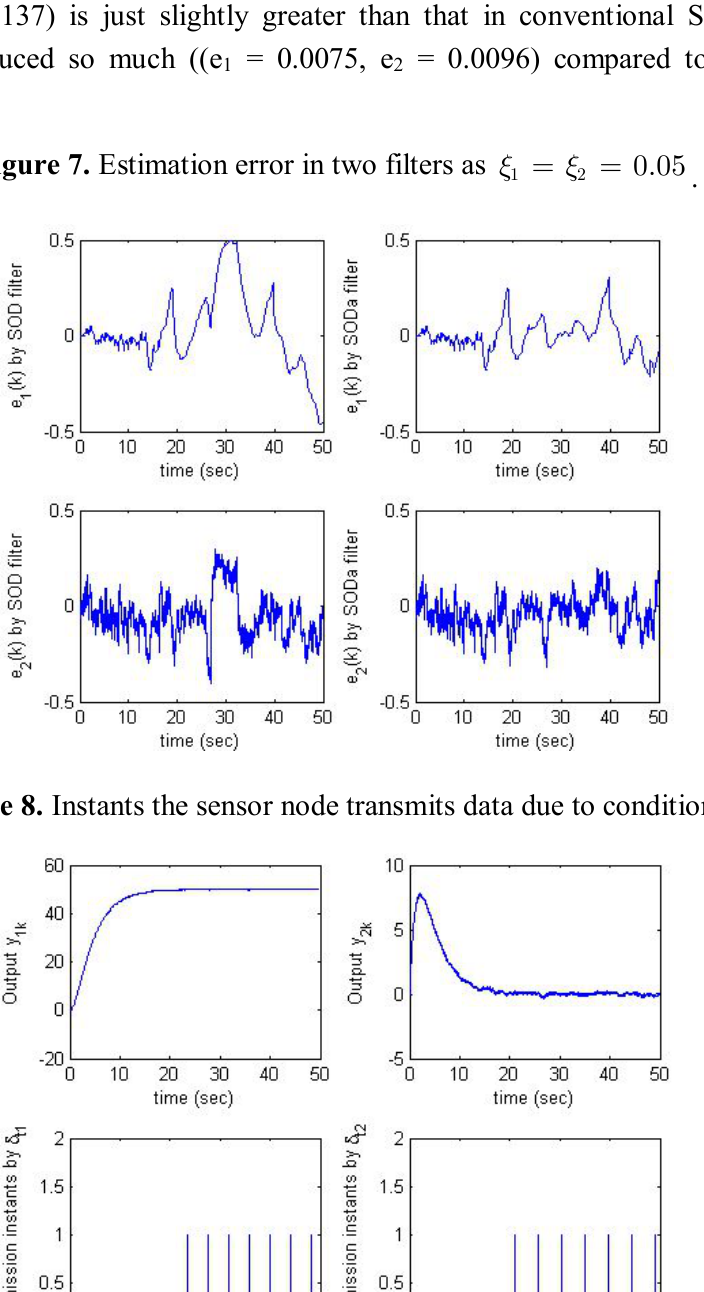
Figure 7. Estimation error in two filters as